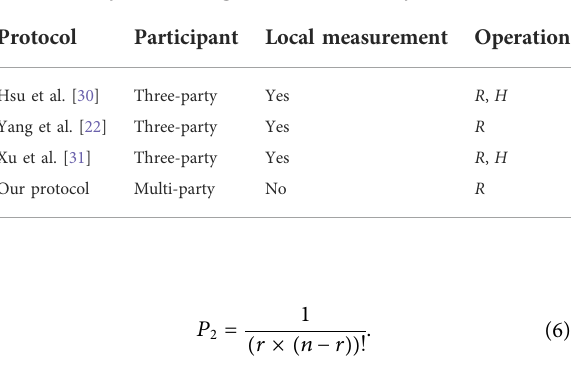
TABLE 2 Comparison among some different QSS protocols.